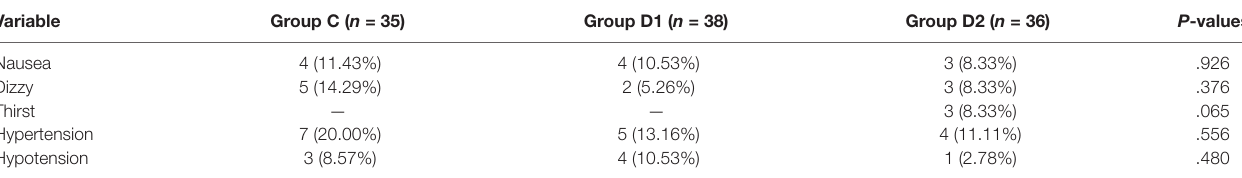
TABLE 6 | Postoperative adverse effects of patients in the three groups.